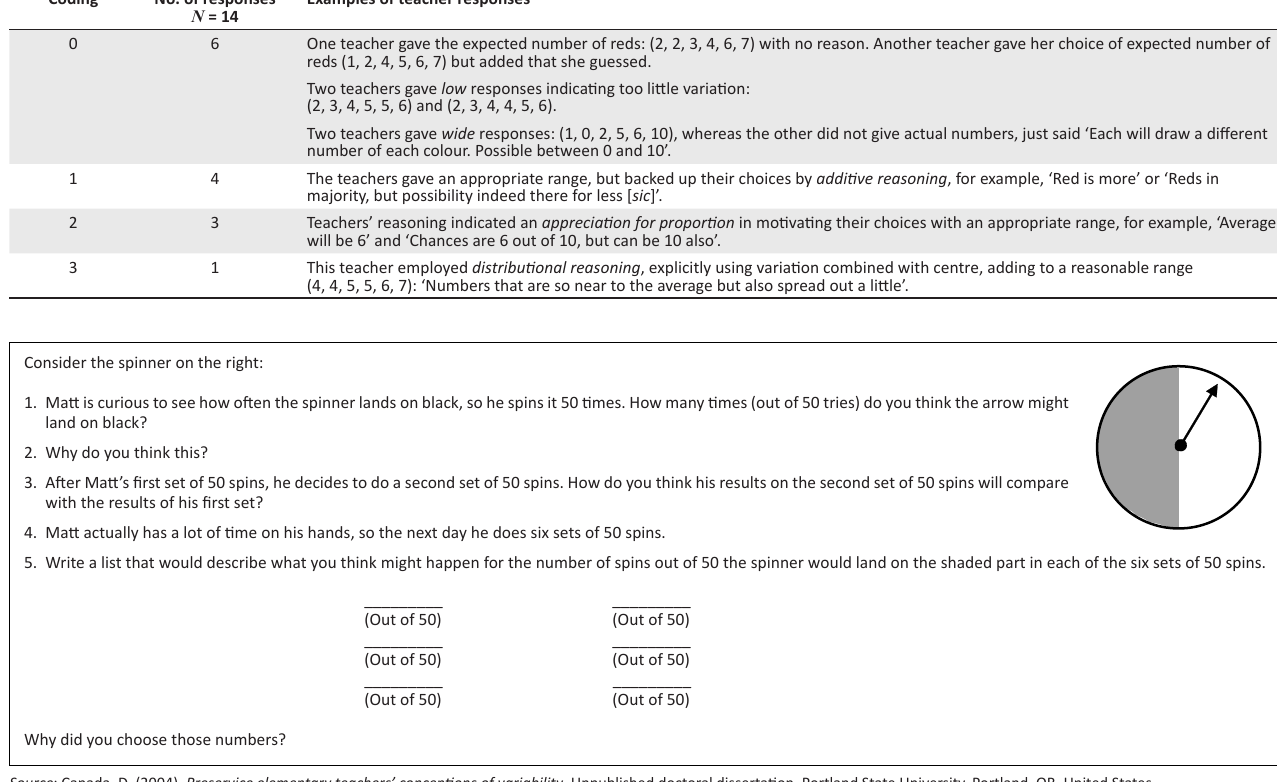
FIGURE 3: The Spinner